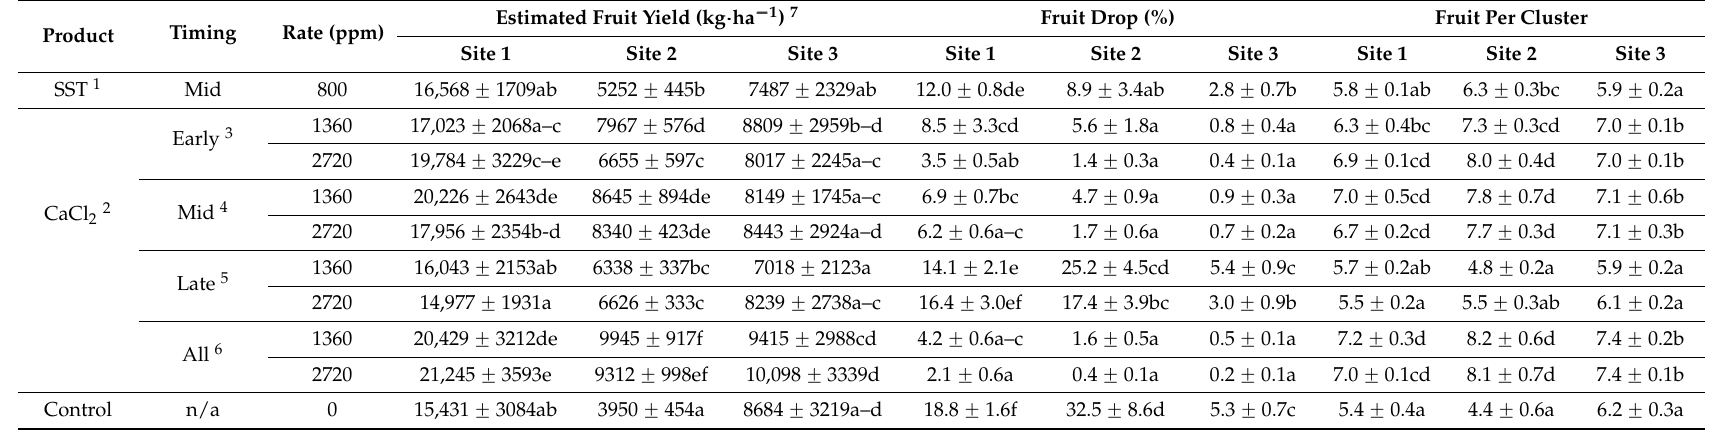
Table 3. Mean ˘ SE estimated fruit yield, pre-mature green fruit drop and fruit per cluster in ‘Draper’ highbush blueberry in response to foliar Ca application rates and timings across three farm sites in the Fraser Valley, British Columbia, Canada in